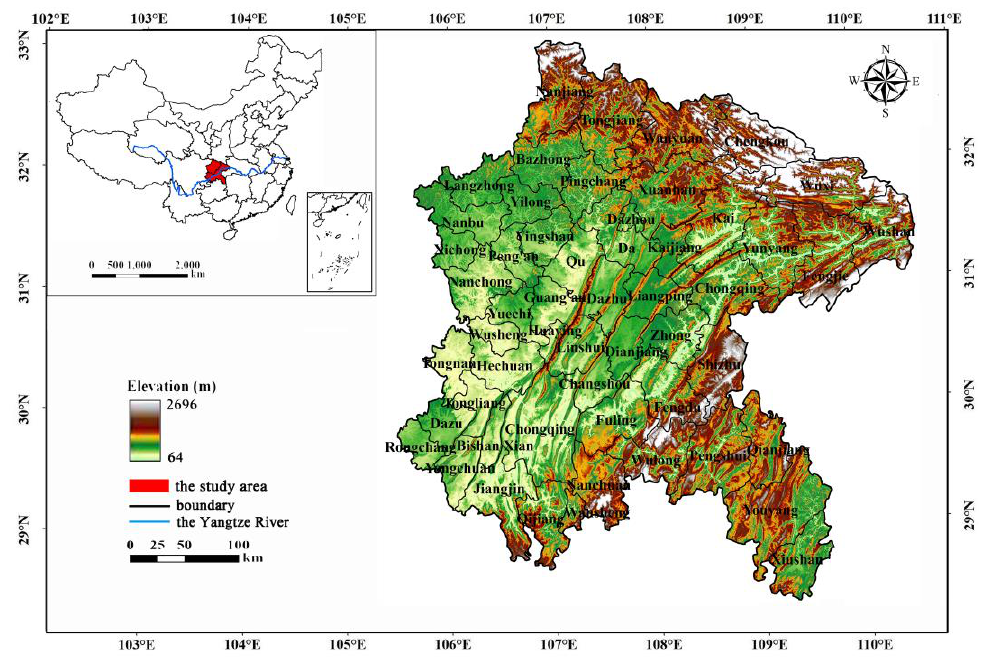
Figure 1. The location of the Eastern Sichuan Region (ESR).